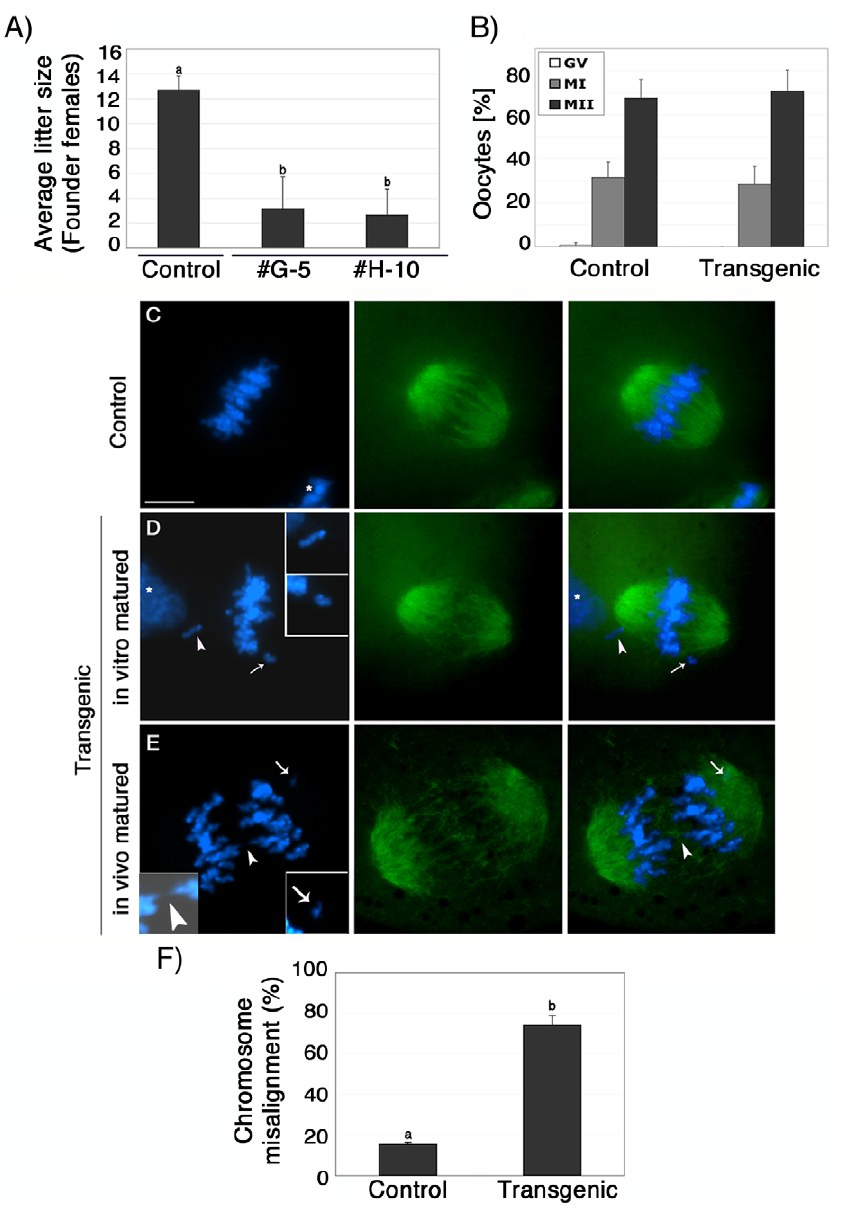
Figure 2. Lack of ATRX function disrupts chromosome alignment at the metaphase II spindle and results in severe sub fertility. ( A ) Control and transgenic female founders were continuously housed with fertile males for a period of 7 months. Transgenic females presented a significant reduction in average litter size ( P , 0.001). ( B ) Proportion of oocytes at the germinal vesicle (GV), metaphase I (MI), or metaphase II (MII) stage following 14 h of in vitro maturation. Selective ablation of ATRX has no effect on the progression of meiosis. ( C ) Control in vitro matured oocytes show proper chromosome alignment at the metaphase II spindle. In contrast, transgenic oocytes exhibit a spectrum of chromosome segregation defects following maturation in vitro and in vivo including ( D ) presence of single chromatids (insets) and ( E ) formation of chromosome bridges during premature anaphase II onset (arrowhead, inset shows overexposed DAPI image) as well as lagging chromosomes (arrow and inset). Asterisks indicate the position of the polar body. ( F ) Proportion of in vitro matured oocytes with misaligned chromosomes. Data are presented as the mean 6 s.d. of three independent experiments. Scale bar =10 m m.